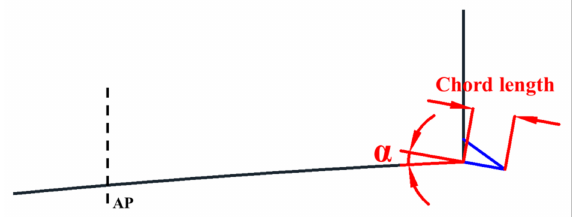
Figure 9. Definition of the design parameters of the stern flap.